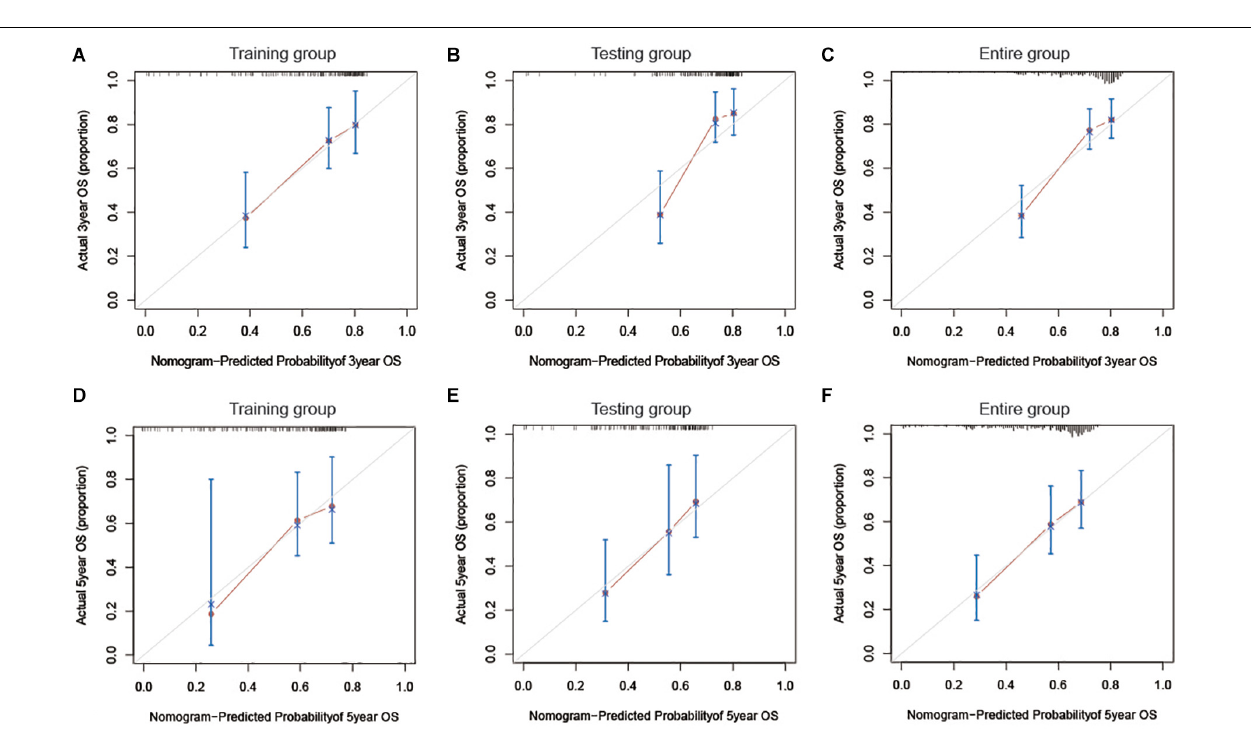
Frontiers in Genetics |